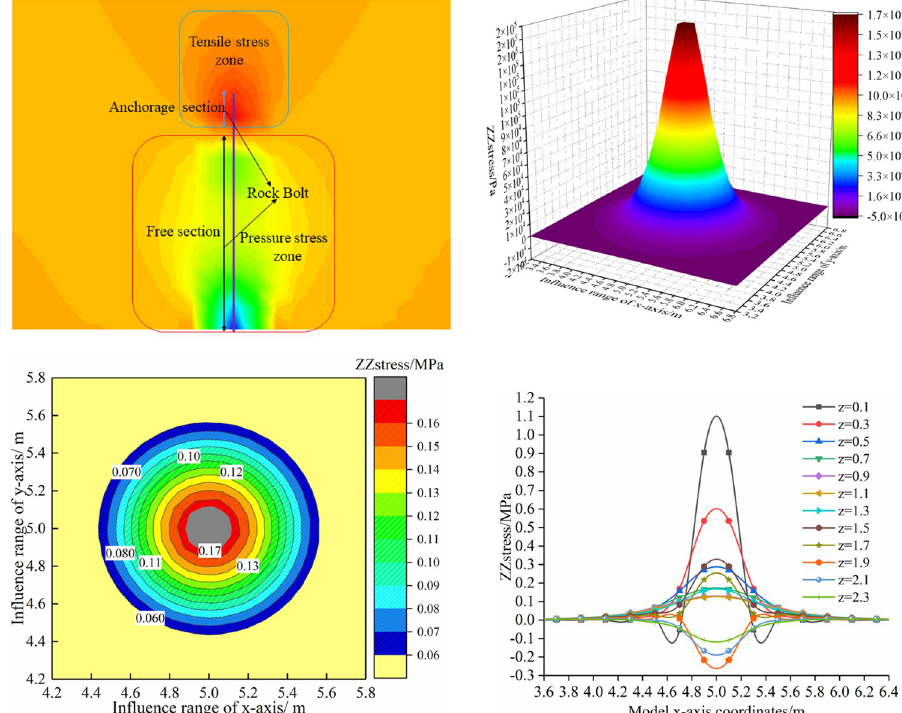
Fig 2. Distribution of stress field under single bolt supporting.